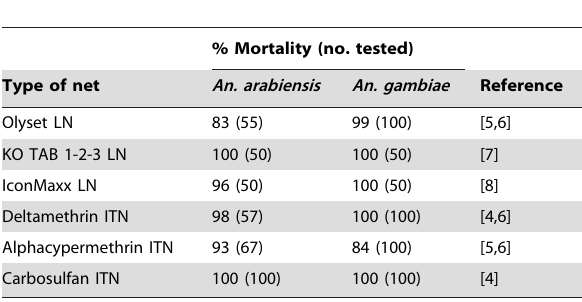
Table 2. Cone bioassay tests on treated nets using insectary reared mosquitoes.